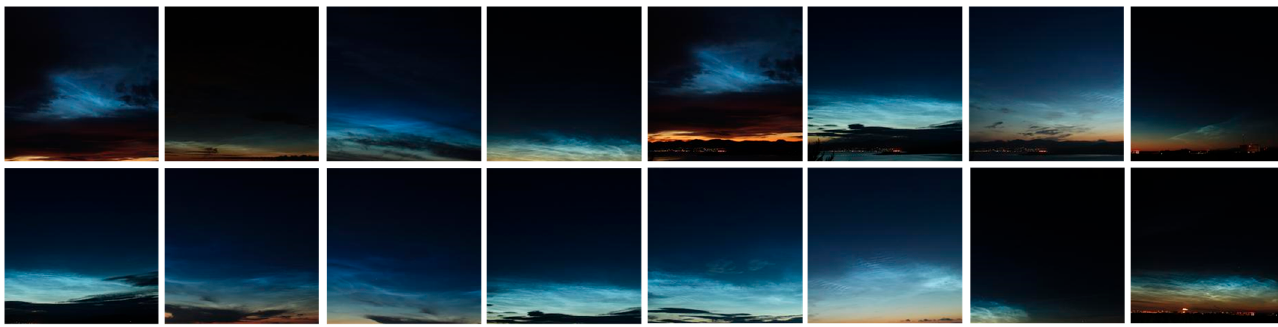
Figure A1. Randomly selected training dataset: images within yellow square contains small to large concentration of noctilucent cloud and are considered as NLC images and the rest with other category.